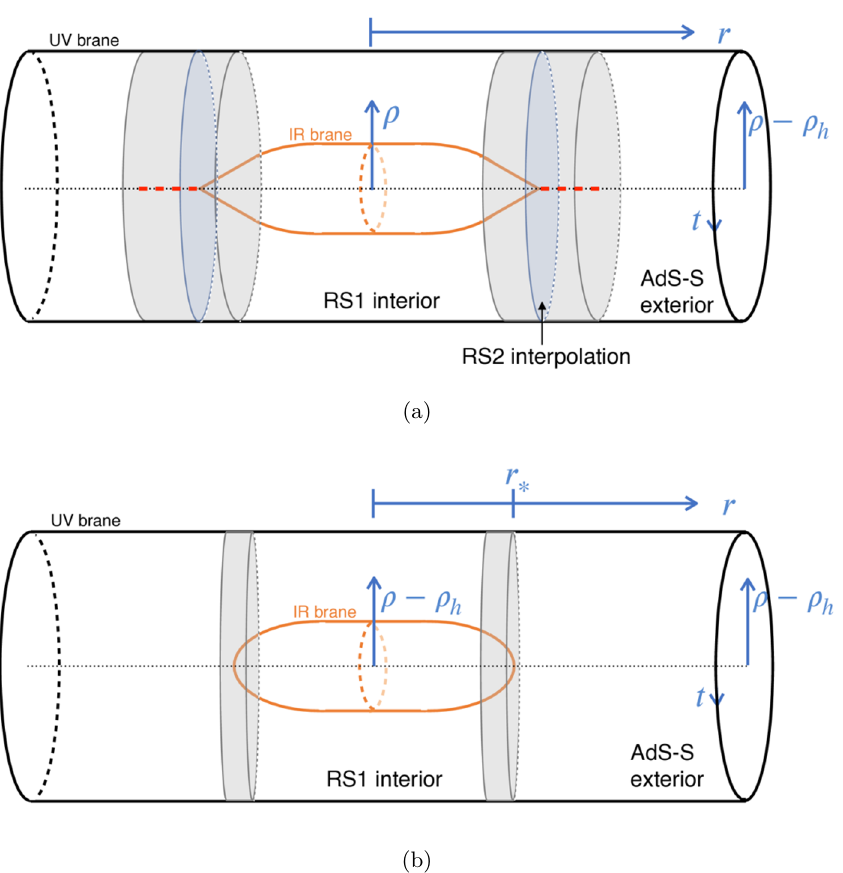
Figure 1. (a) Topology of the bounce proposed in ref. [24]. In the gray region the description of the ansatz gets out of 4D radion EFT as well as 5D EFT control. The orange surface shows the IR brane, and the red dashed line indicates the adjustment of ρ h between its equilibrium AdS-S value to zero at the RS2 limit. (b) Smooth bounce topology/configuration proposed in this work, describable within 5D EFT. The IR brane (the orange surface) is smoothly capped off at the horizon. In the gray region, the (two-derivative) 4D radion EFT gets out of control, but the bounce can still be described within 5D